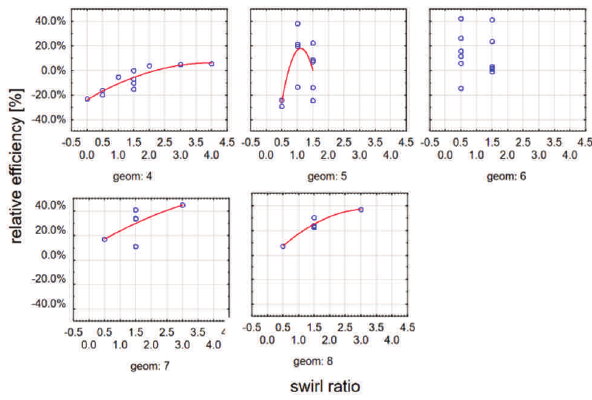
Fig. 3. Relative efficiency and swirl ratio for different geometries